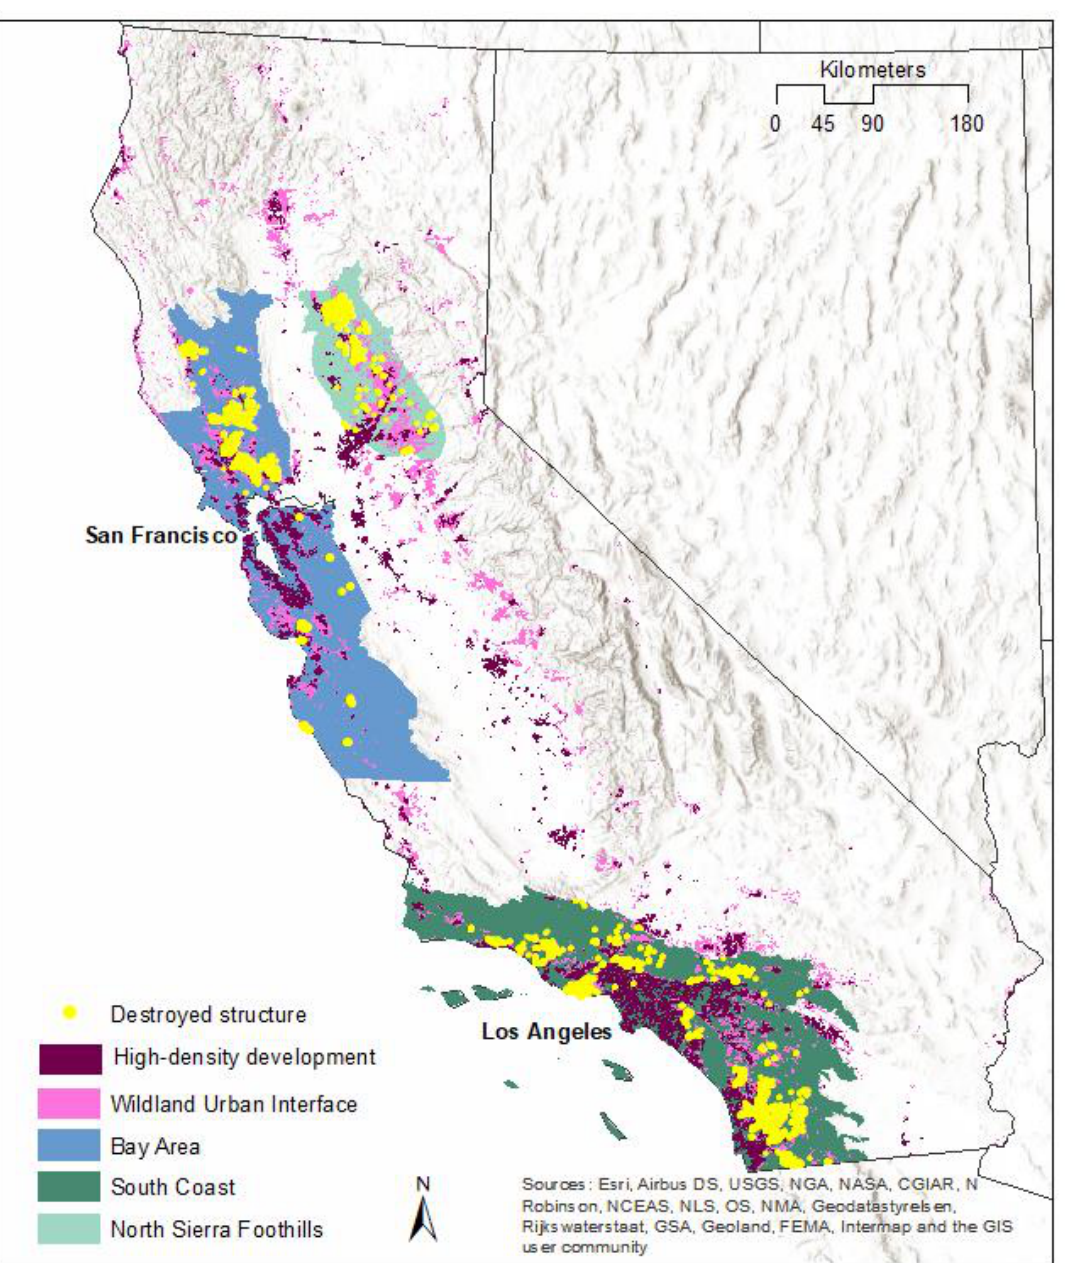
Figure 1. The Bay Area, North Sierra Foothills, and South Coast study regions in California, USA. The North Sierra Foothills region contains 9,404,800 ha of land spanning the gradient from the central valley on the west to the northern cismontane Sierra Nevada on the east (Figure 1). With a mean of 1.0 people per ha, this study region has the lowest population density, with no major cities within. However, the region has the highest proportion of WUI of the three regions, with 37% area mapped as WUI as of 2010 and an average distance to WUI being 2.01 km. The vegetation is primarily grassland and chaparral at the lowest elevations and transitions eastward and higher in elevation through mixed evergreen forests to pine- and fir-dominated forests, with small areas of sub-alpine forests at the highest elevations. This region has had a growing number of destructive fires